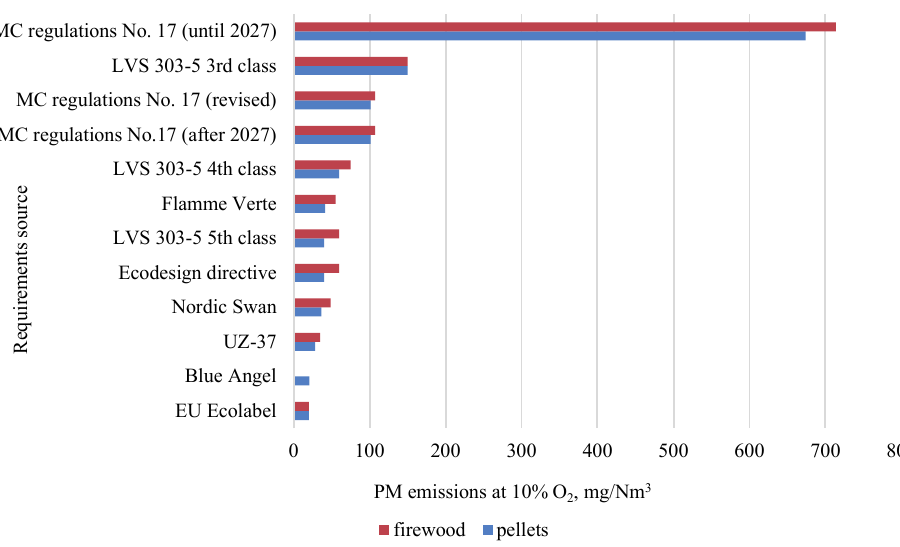
Fig. 6. Requirements for PM emissions for pellet and firewood